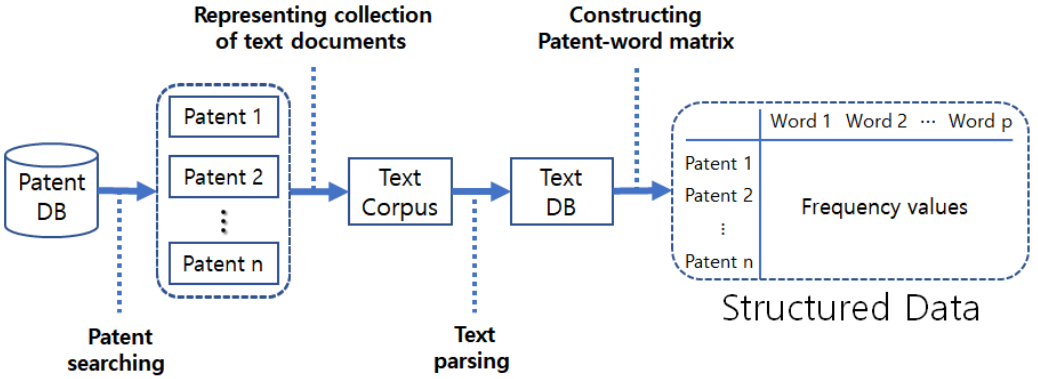
Figure 2. Constructing structured data using text mining.